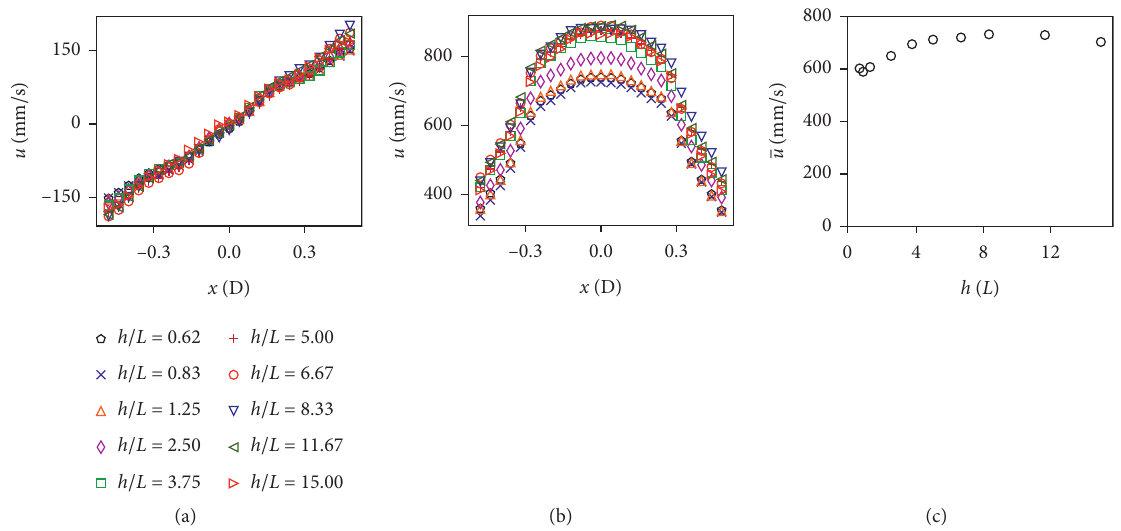
Figure 7: Results of velocity for different pebble bed heights h . (a) Horizontal profiles of the horizontal velocity u . (b) Horizontal profiles of the vertical velocity v . (c) Mean vertical velocity v versus the height of the particle bed h normalized by hopper width L